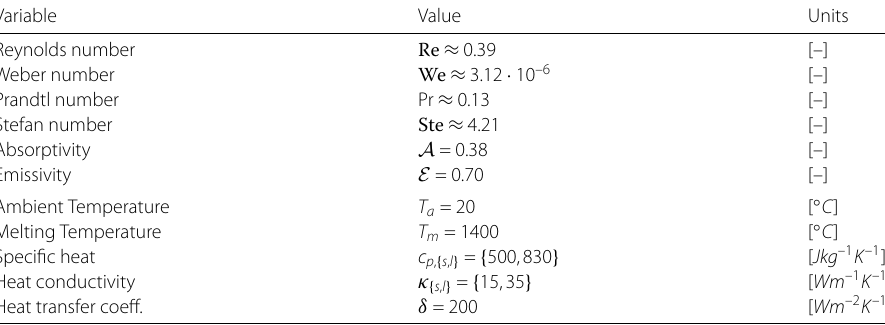
Table 1 General material and process parameters, the material is 1.4301 steel Variable Value Units Reynolds number Re ≈